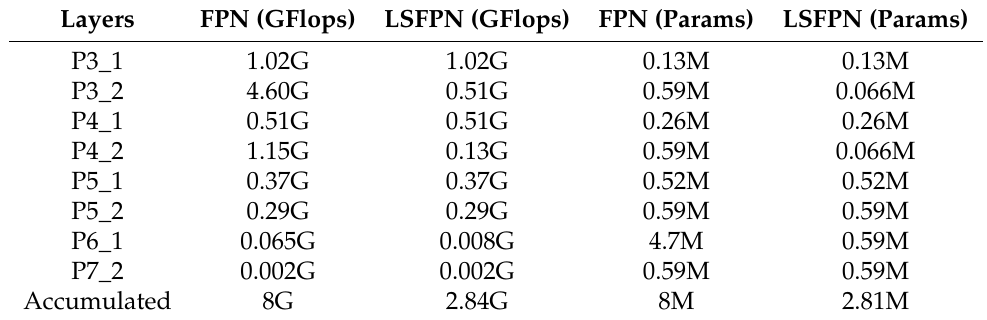
Table 4. Analysis of LSFPN’s computation and parameter amount under a single detection head.